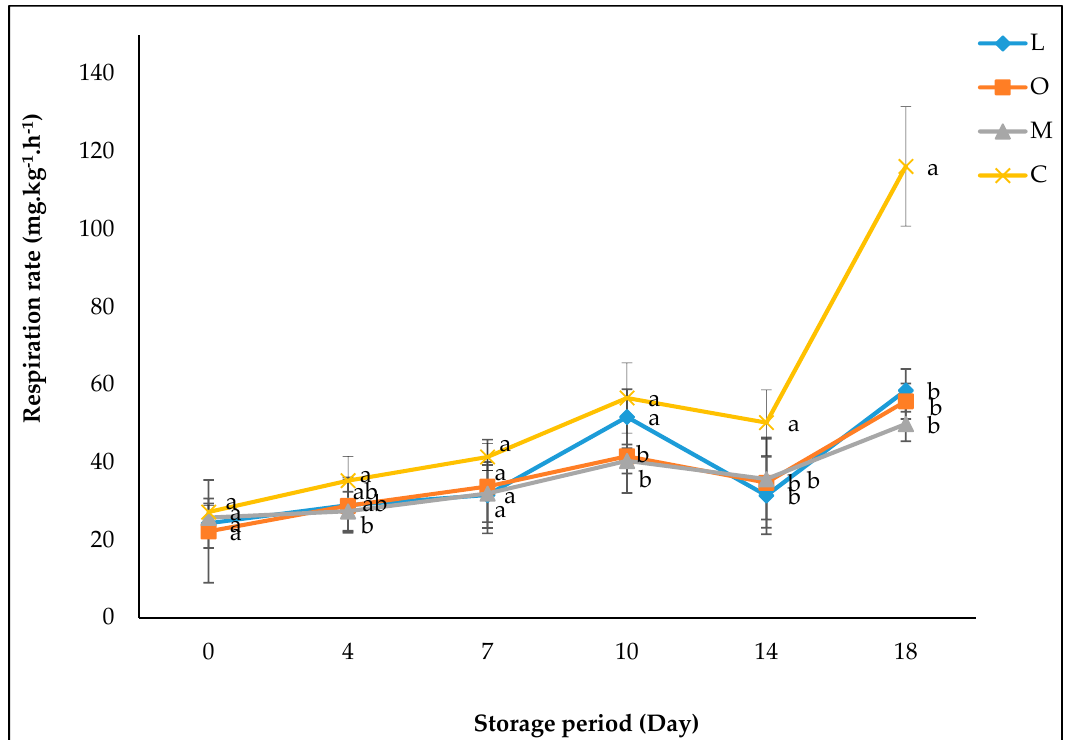
indicate significant difference between treated and control fruits at each storage period (Duncan’s of 95%).